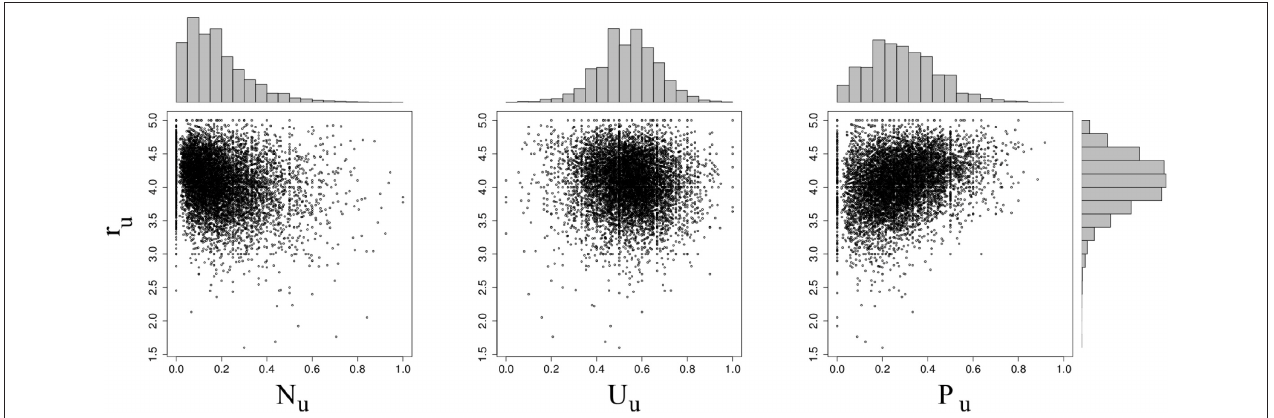
FIGURE 8 | Scatter plot of user average ratings r u vs. user emotional ratios for negative ( N u , left), neutral ( U u , right), and positive ( P u , right) reviews. The histograms show the distributions of each variable.